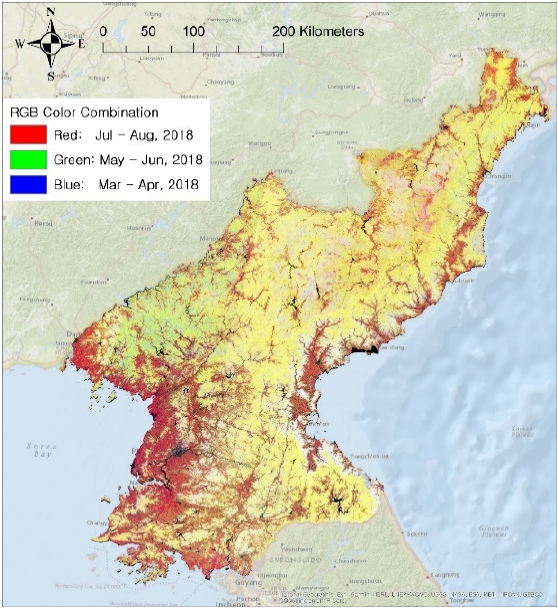
Figure 4. RGB Color Combination Visualization of Multi-band NDVI.